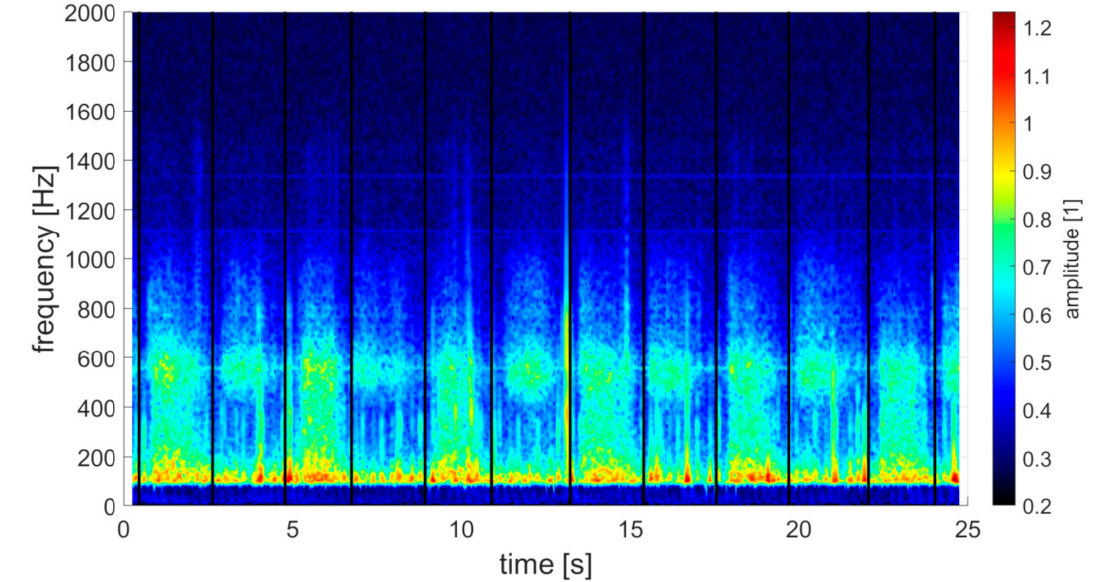
Figure 8. The frequency spectrum of the respiratory sound with black, vertical border lines—Patient No. 1. In the spectrum, there are distinct sound defects caused by the manipulation with record equipment (amplitude distinct areas between 200 Hz–600 Hz with time duration roughly 0.02 s). In the spectrum, two distinct horizontal lines are also obvious—1110 Hz and 1330 Hz. These are most likely an effect of the background